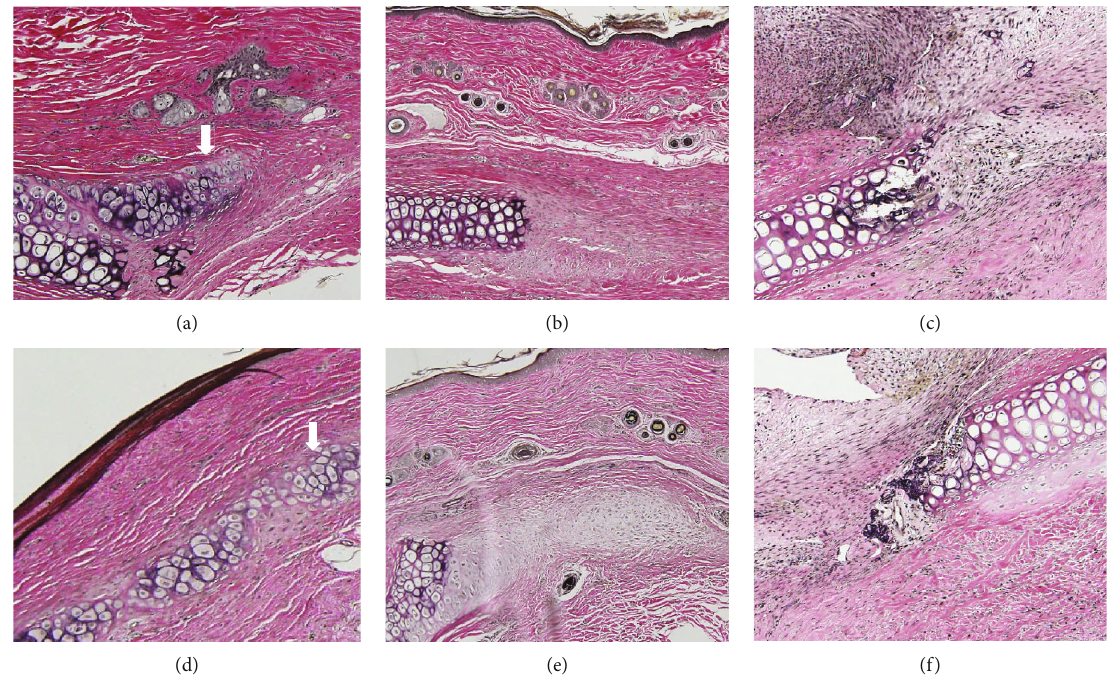
Figure 5: Immunohistochemical detection of elastin. New cartilage (arrow) was evident in the adipose-derived stromal cell (ADSC) group at 4 (a) and 8 weeks (d) after ADSC injection. Small amounts of ECM and fi brous tissue were observed, respectively, in the secretome (b, e) and PBS (c, f) groups at 4 and 8 weeks (magni fi cation,